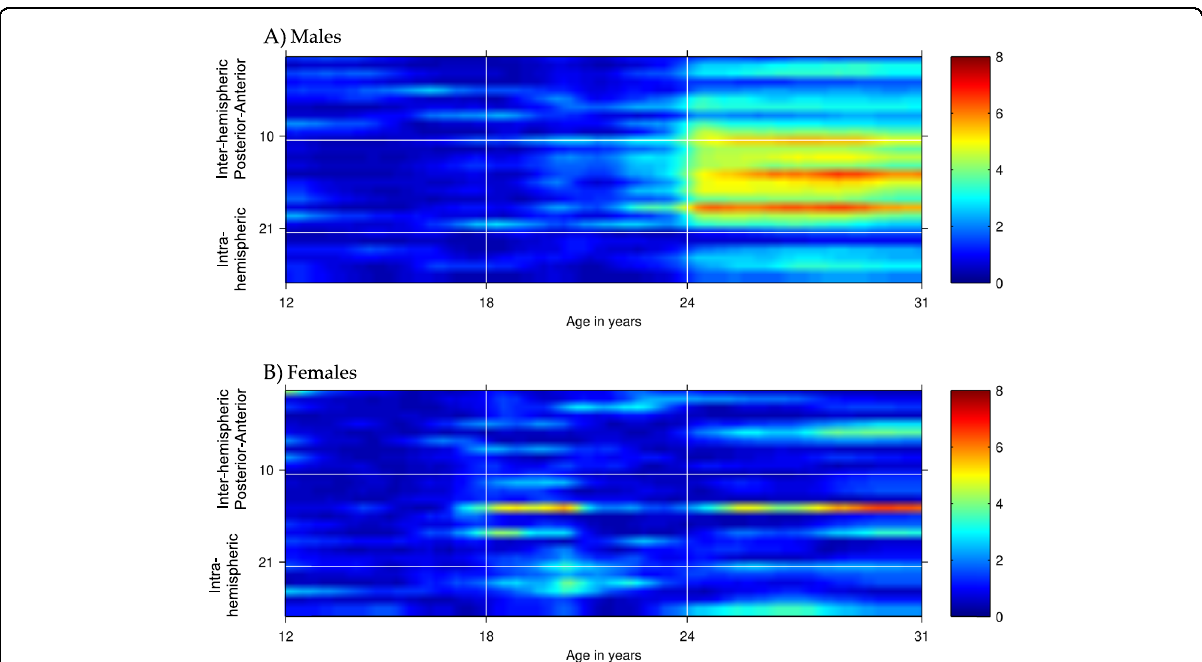
Fig. 5 Association of bipolar disorder PRS with interhemispheric and intrahemispheric high-alpha EEG coherence networks in males (A) and females (B) from ages 12 – 31. Age is represented on the x -axis and coherences are represented on the y -axis, with numbering 1 – 27 corresponding to coherences between bipolar electrode pairs illustrated in Fig. 1. Regional divisions are marked with horizontal white grid lines: 1 – 10 anterior (frontal-central); 11 – 21 posterior (central-parietal-occipital); 22 – 27 left and right intrahemispheric. Color values in the main panels indicate levels of signi fi cance ( p -values on a negative log 10 scale) as indicated by the color bars on the